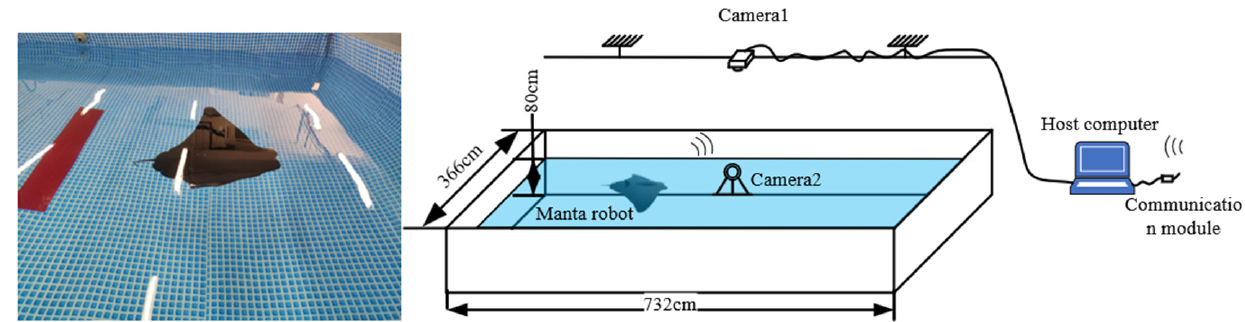
Figure 7. Experimental site for manta robot. At the beginning of the experiment, the manta robot was floating stationary in an indoor pool measuring 73.2 cm × 36.6 cm with a depth of 80 cm. The parameters and commands during the experiment were sent by radio from the onshore host computer, and the underwater camera was placed on one side of the pool to capture video of the manta robot swimming in the longitudinal plane. The underwater camera was placed on one side of the pool to capture video of the manta robot swimming in the horizontal plane.